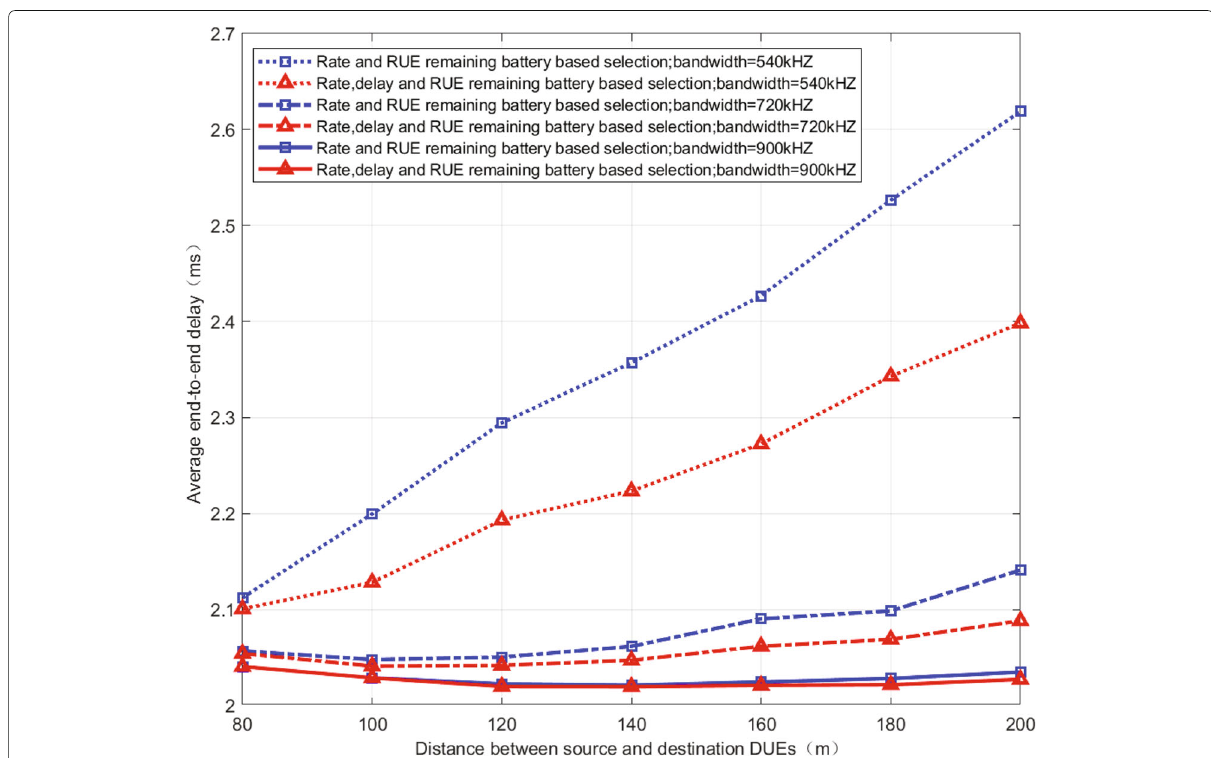
Fig. 9 The average end-to-end delay in different bandwidths for joint network coding and relay selection schemes